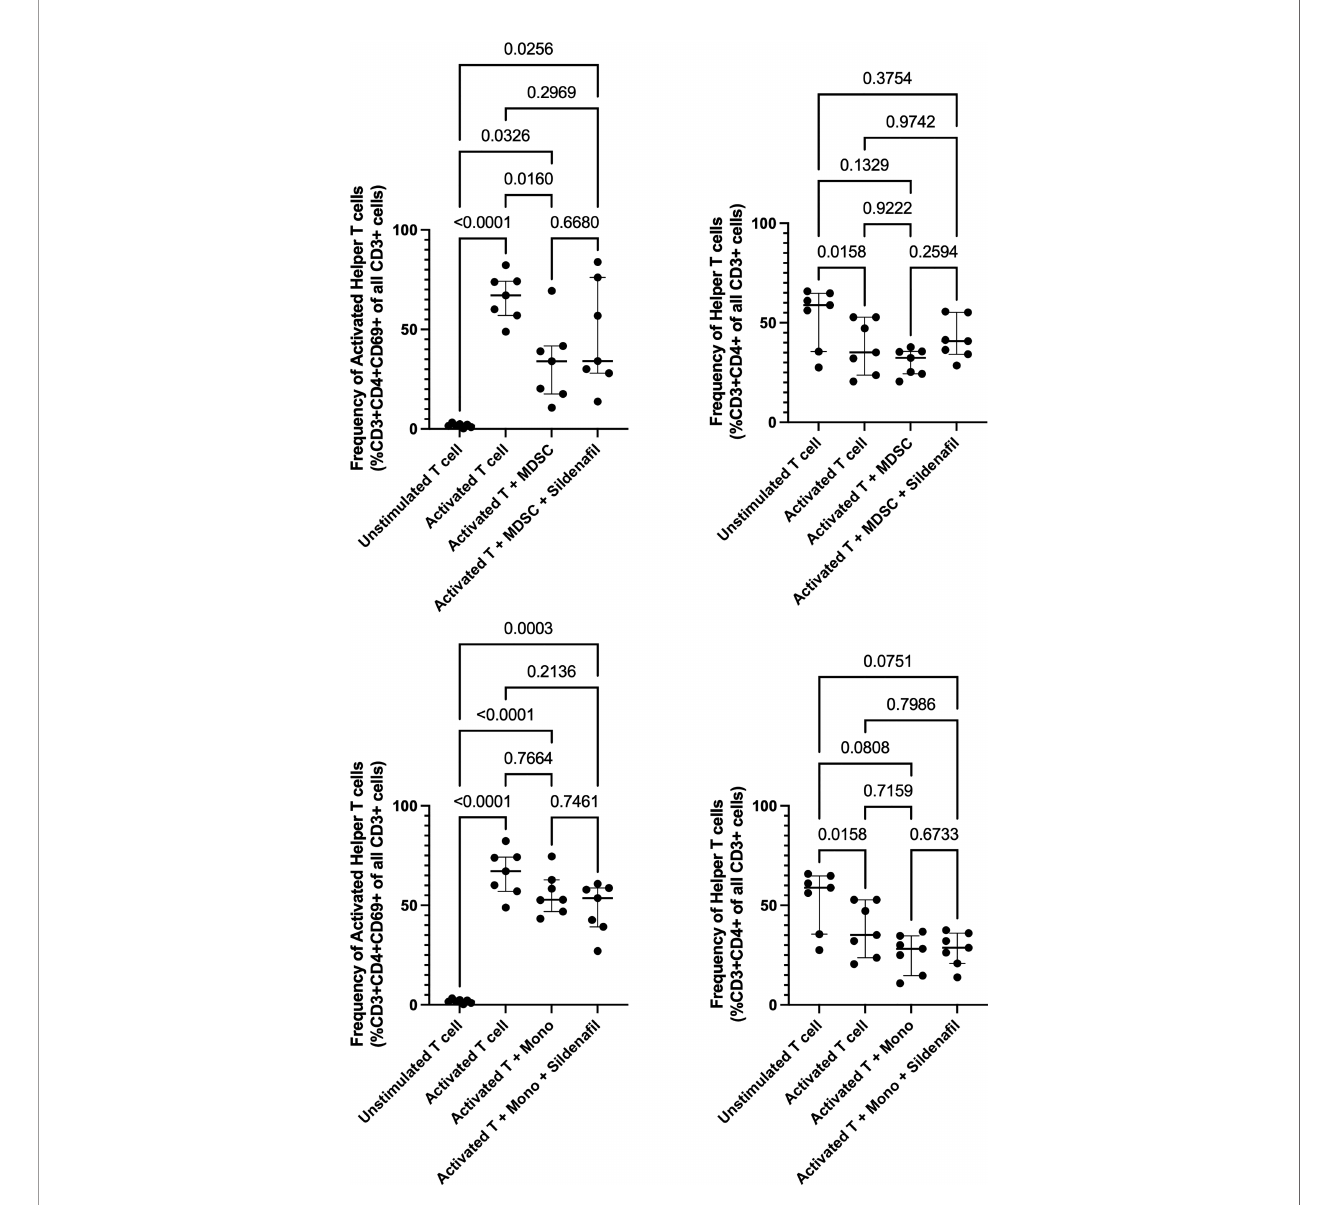
FIGURE 1 | Effect of MDSC on Helper T cell and Helper T cell subset responses. Frequency of Helper T cells (CD3+CD4+) and Helper T cell subsets from in vitro T cell co-culture of autologous T cells (CD3+ cells), MDSC (HLA-CD33+ cells) and control monocytes (HLA+ cells) isolated from PBMC of individuals with active TB disease (n = 7). Plots show individual T cell replicates. Panels (A-D) D ’ Agostino & Pearson test measured normality. Repeated measures one way ANOVA with Sidak ’ s multiple comparisons test (parametric data) and Friedman test (non-parametric data). P<0.05 was considered signi fi